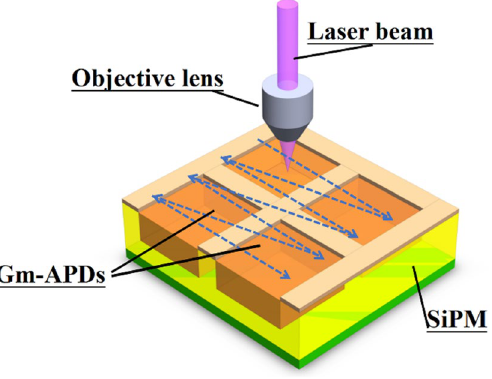
Figure 2. Illustration of the scanning process of the focused laser spot relative to SiPM (blue dotted lines with arrows represent the scanning route; Gm-APD Geiger mode avalanche